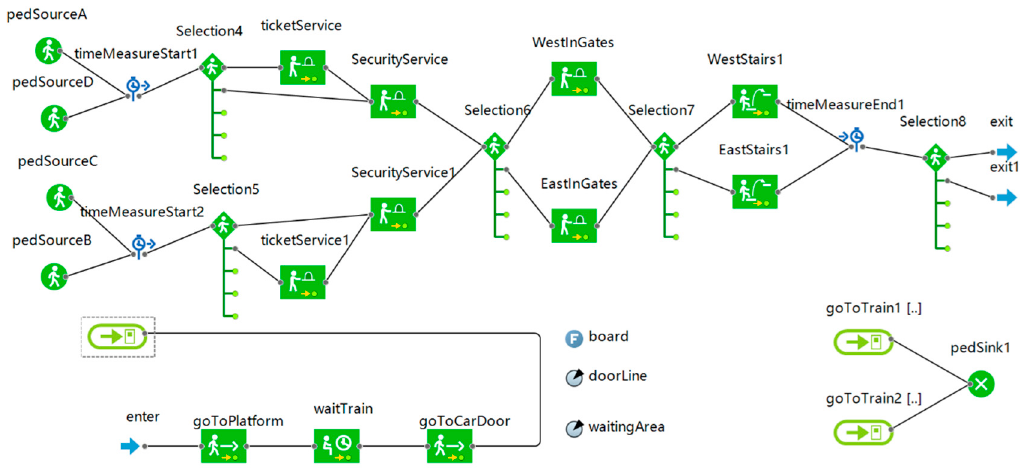
Figure 6. The outbound pedestrian behavior model.